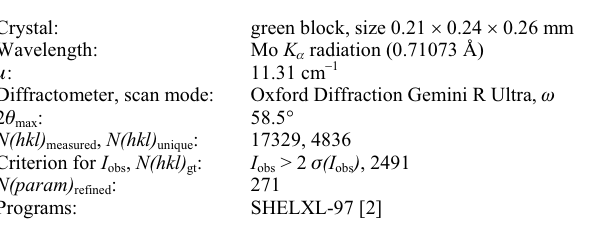
Table 1. Data collection and handling.